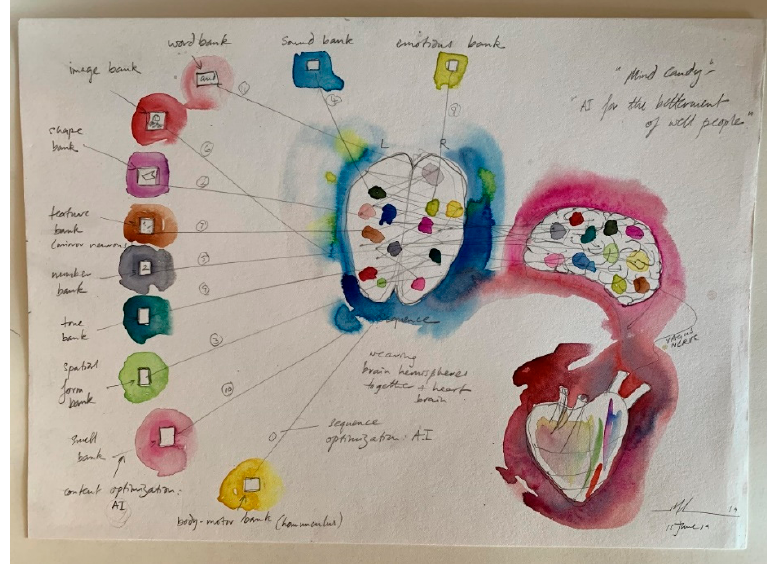
Figure 15. Feedback loop idea for Kernel of Consciousness showing how imagery and other sensory inputs are sorted by a machine learning filter to stimulate a large number of brain sectors in sequence to optimize brain stimulation in stroke patients.